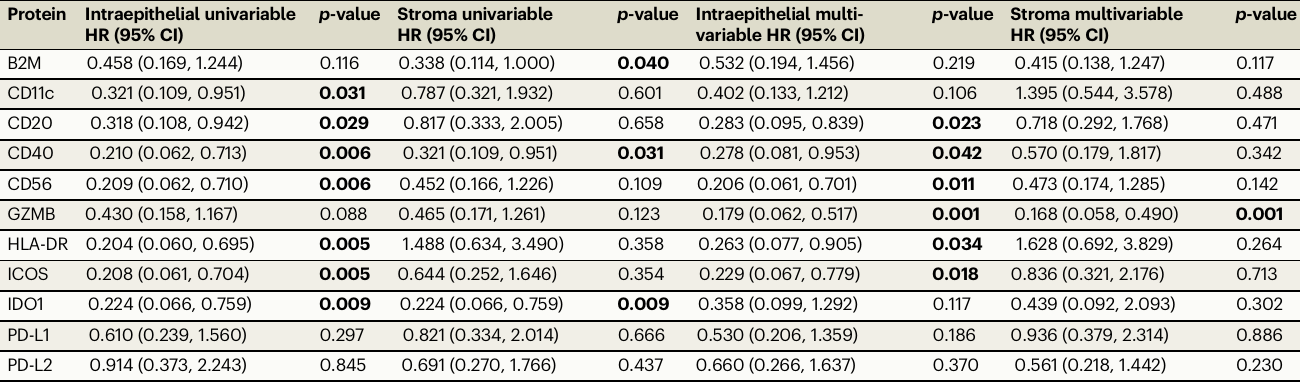
Table 2 | Cox hazard ratios (HRs) for recurrence in FinXX samples Protein Intraepithelial univariable HR (95% CI)